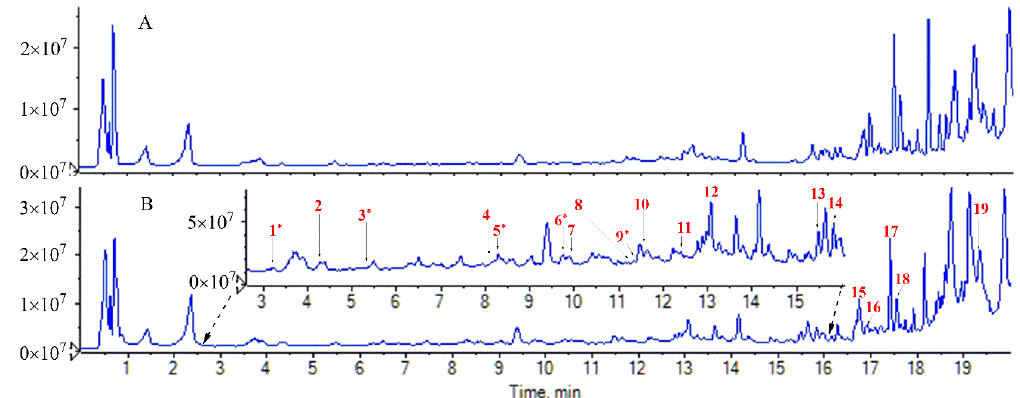
Figure 1. TIC chromatograms. ( A ) Blank plasma; ( B ) plasma after oral administration of Z. nitidum decoction.